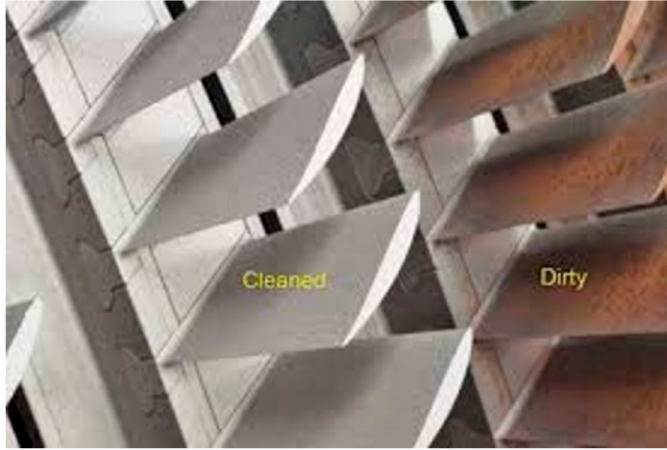
Figure 3. Clean and fouling conditions in compressor